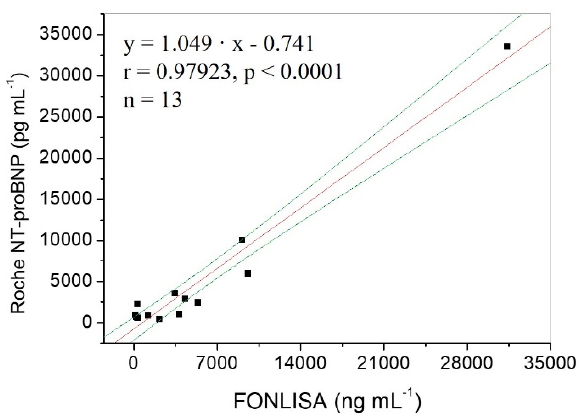
Figure 7. Correlation of results between FONLISA and Roche Cobas e411 for detection of NT-proBNP in blood plasma samples. The red line is the regression line, and the blue dashed lines are the 95% confidence intervals for the regression model.